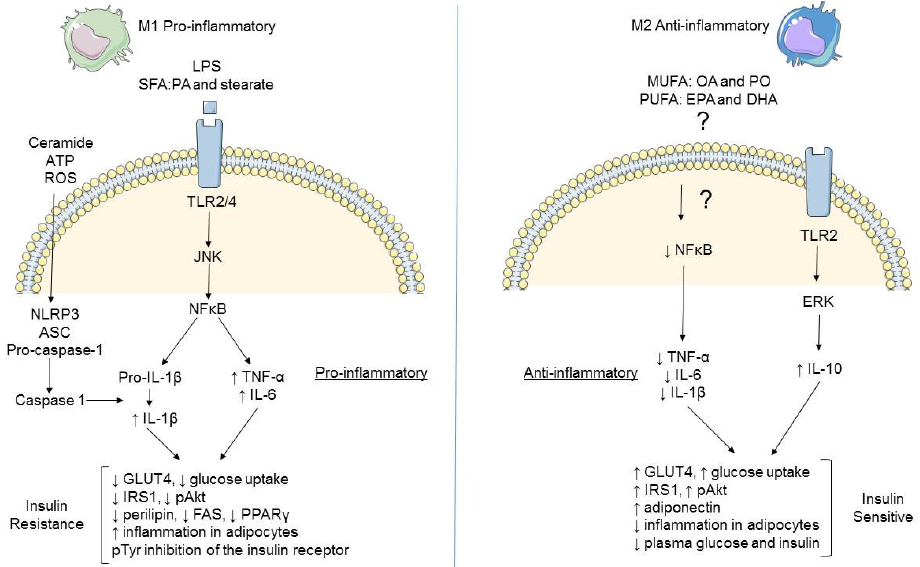
Figure 2. Inflammatory pathways in M1 and M2 macrophages. M1 pro-inflammatory macrophages are induced by saturated fatty acids (SFA) and lipopolysaccharide (LPS) to generate pro-inflammatory signaling through nuclear factor kappa B (NFkB) to produce tumour necrosis factor alpha (TNF- α ) and interleukin-6 (IL-6). Subsequent stimulation by ceramides, adenosine triphosphate (ATP) or reactive oxygen species (ROS) leads to assembly of the nod-like receptor (Nlrp3) inflammasome and processing of pro-interleukin-1 beta (IL1 β ) to active IL-1 β through cleavage by caspase-1. Pro-inflammatory cytokines negatively impact glucose homeostasis and insulin signaling, resulting in insulin resistance in neighbouring cells. M2 anti-inflammatory macrophages are induced by monounsaturated fatty acids (MUFA) and polyunsaturated fatty acids (PUFA) acting via receptors, which are currently unidentified, with increased interleukin-10 (IL-10) secretion along with a reduction in pro-inflammatory markers. This results in improved insulin sensitivity and a less inflammatory environment. TLR = toll-like receptor, ASC = apoptosis like speck protein, GLUT4 = glucose transporter type 4, IRS = insulin receptor substrate, FAS = fatty acid synthase. PPAR γ = peroxisome proliferator activated receptor gamma, OA = oleic acid, PO = palmitoleate, EPA = eicosapentaenoic acid, DHA = docosahexaenoic, ERK = extracellular regulated kinase. (This figure was prepared using the Servier medical art website